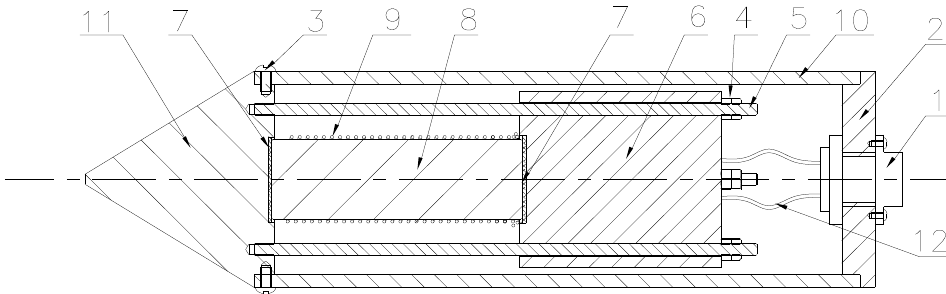
Figure. 2. Structural diagram of the GMS ultrasonic actuator. (1) Plug seat; (2) Rear cover; (3) Screw; (4) Nut; (5) Pre-tension screws; (6) Cylindrical steel mass; (7) Backing gasket; (8) GMS rod; (9) Magnetic exciting coil; (10) Outer cover; (11) Energy-focusing head; (12) Wire to drive the circuit.